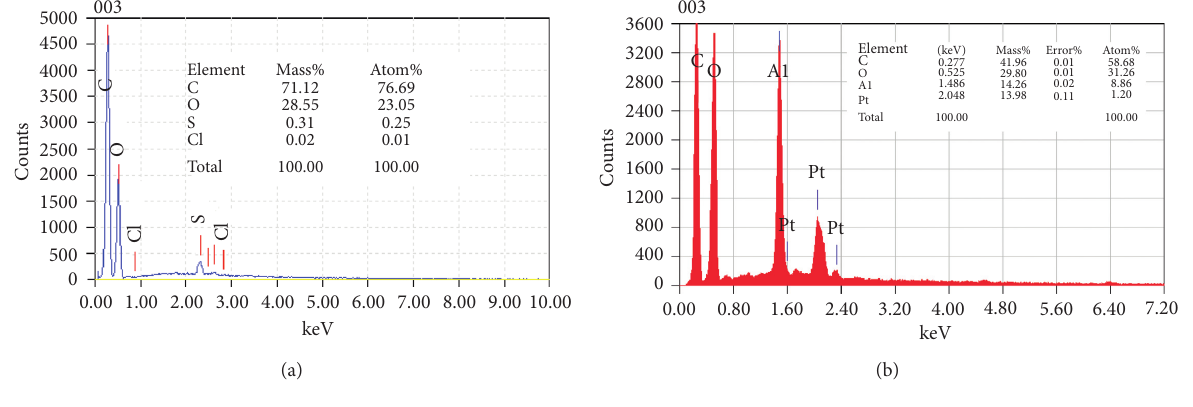
Figure 3: EDX spectra of GO (a) and PtAl/rGO catalyst